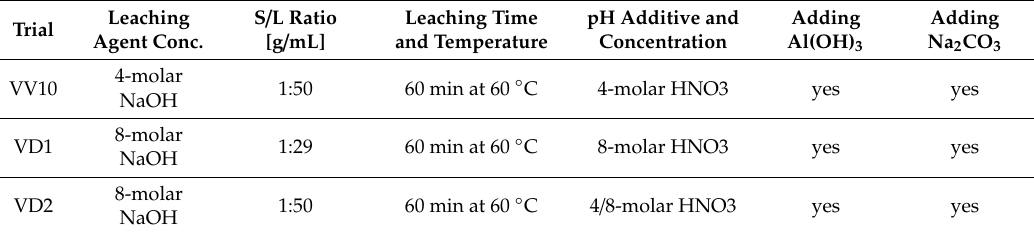
Table 6. NaOH parameter combinations applied in the